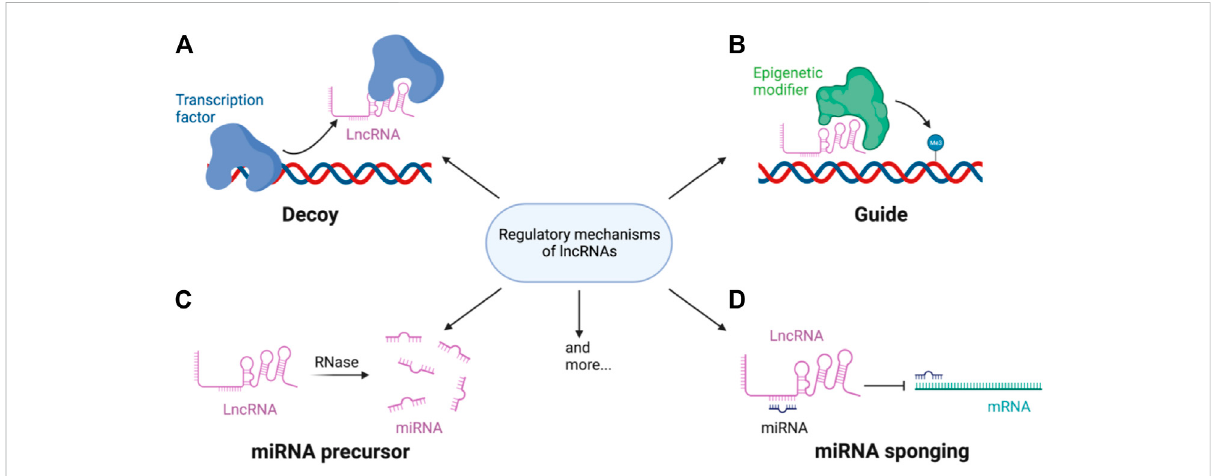
FIGURE 1 Regulatory mechanisms of lncRNA. LncRNAs regulate gene expression through (A) decoying or guiding transcription factors and/or (B) epigenetic modi fi er to the target loci. LncRNAs can also be (C) processed into mature miRNAs or (D) bind miRNA to sponge the miRNAs miRNA mediated gene repression or mRNA